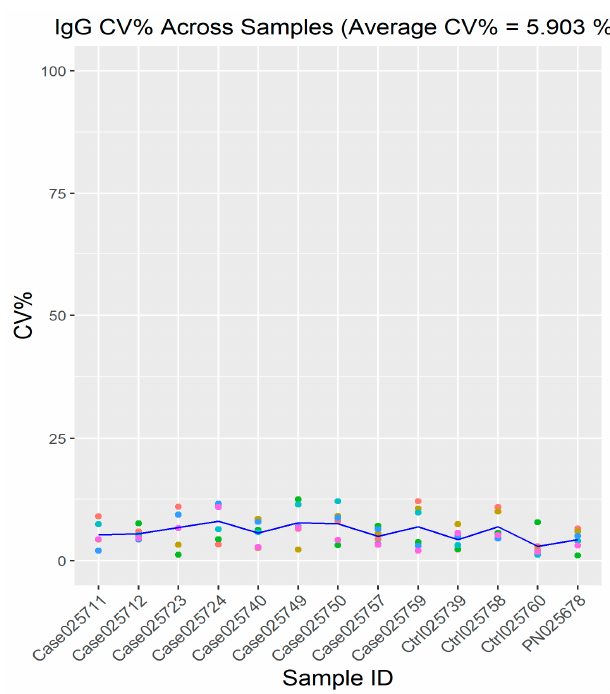
Figure 3. Intra-protein, intra-slide and inter-array CV% of six IgG replica spots across all samples. The mean CV% for all samples was found to be 5.903%. Blue line represents the mean CV% for each sample.